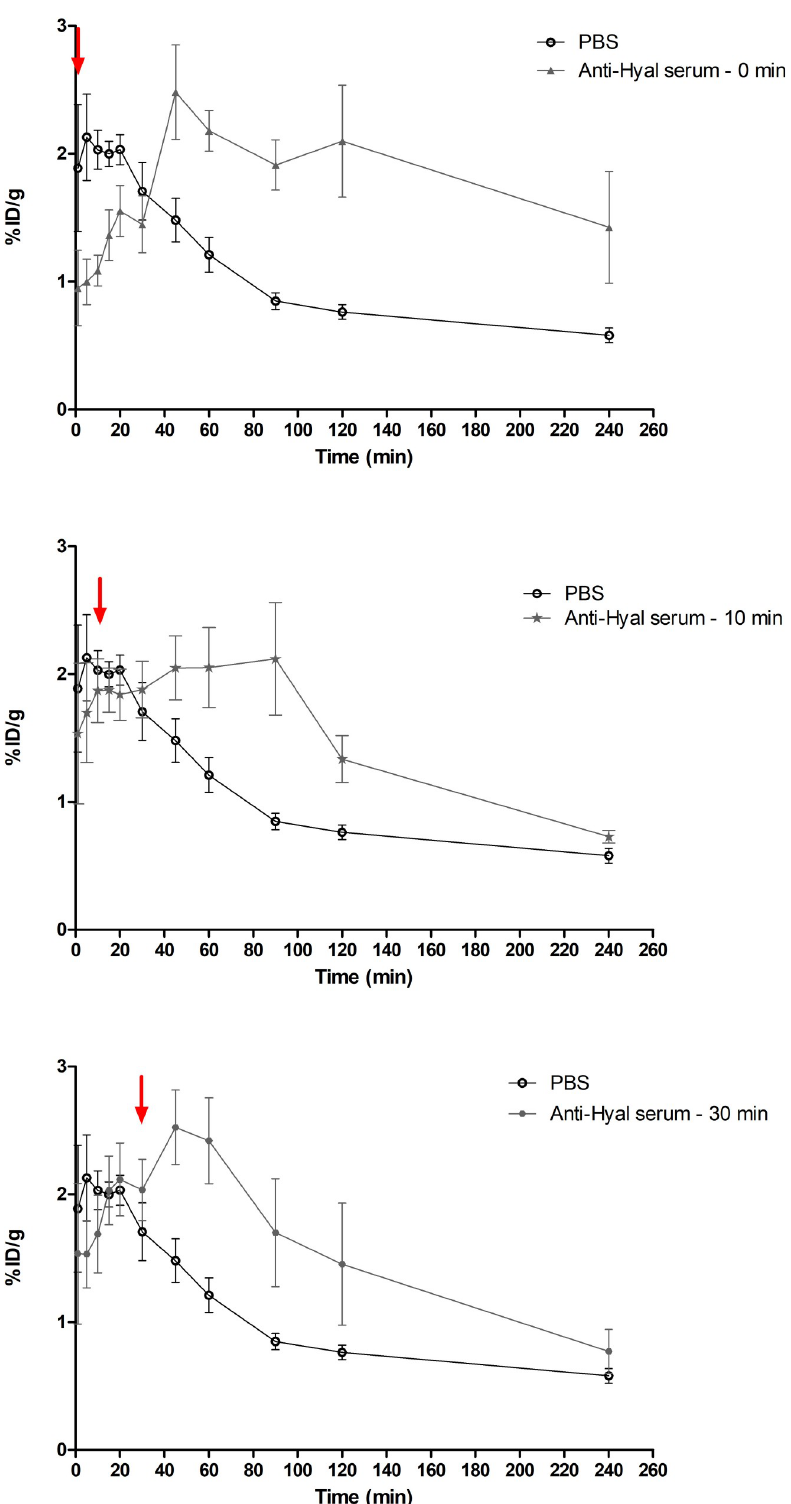
Fig 6. Hyaluronidase neutralization as a first-aid treatment for scorpion sting. 3.7 MBq of 99m Tc-TsV diluted in PBS was intramuscularly injected in Swiss mice (6–8 weeks old, 24–28 g; n = 6 per group). Subsequently, anti- hyaluronidase serum was injected in the same site of 99m Tc-TsV injection at different times (Anti-Hyal serum; 0, 10,